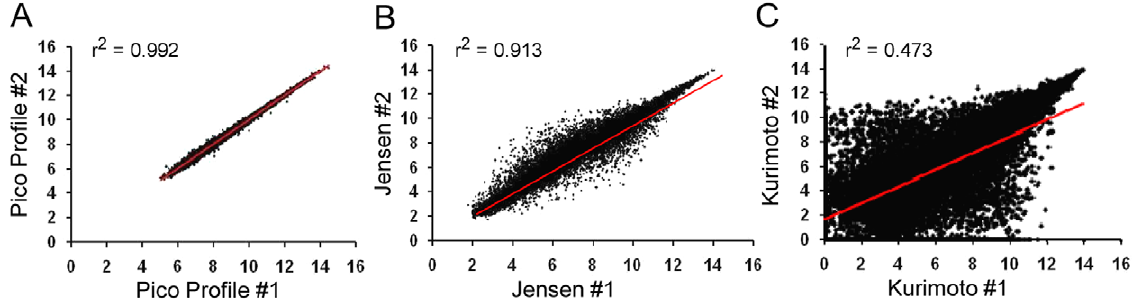
Figure 5. Correlation of expression estimates of expression profiling from picograms RNA. A , correlation of replicates of Pico Profiling from 100 pg RNA. B , correlation of replicates from Jensen’s data set from 50 pg. C , correlation of replicates from Kurimoto’s data set from 10 pg. Expression values are expressed in log2 scale and all measurements of all probe sets are displayed.